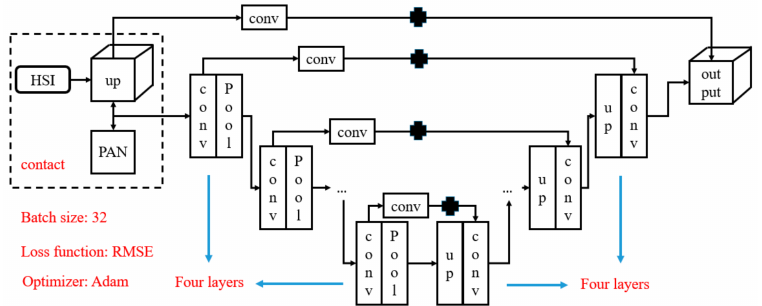
Figure 9. Qualitative details of the proposed EDRN